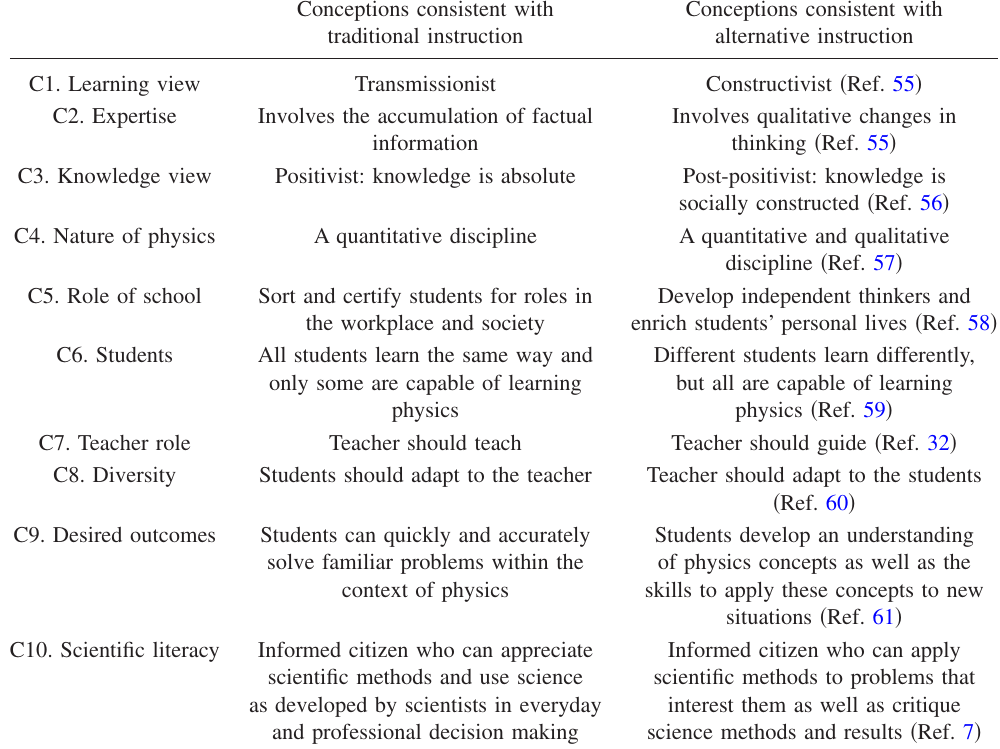
TABLE III. Main categories of